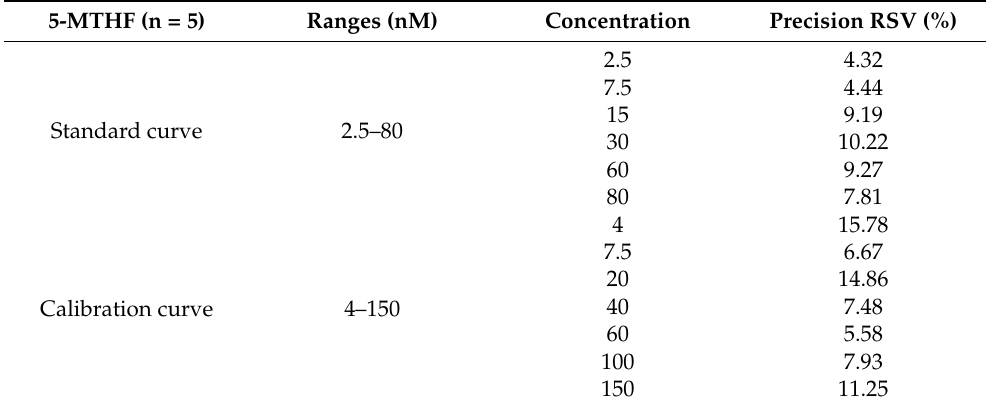
Precision of the 5-methyltetrahydrofolate (5-MTHF) standard and extraction calibration